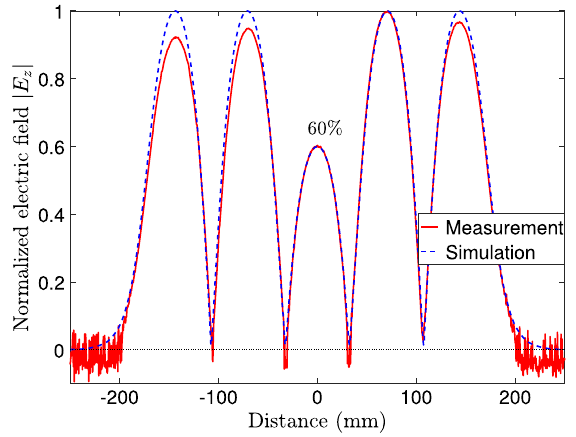
FIG. 4. The design accelerating the gradient profile, compared to the profile measured in the welded cavity using the bead- pulling method. The field in the center cell is intentionally lowered to ensure an equal peak surface magnetic field in every cell.